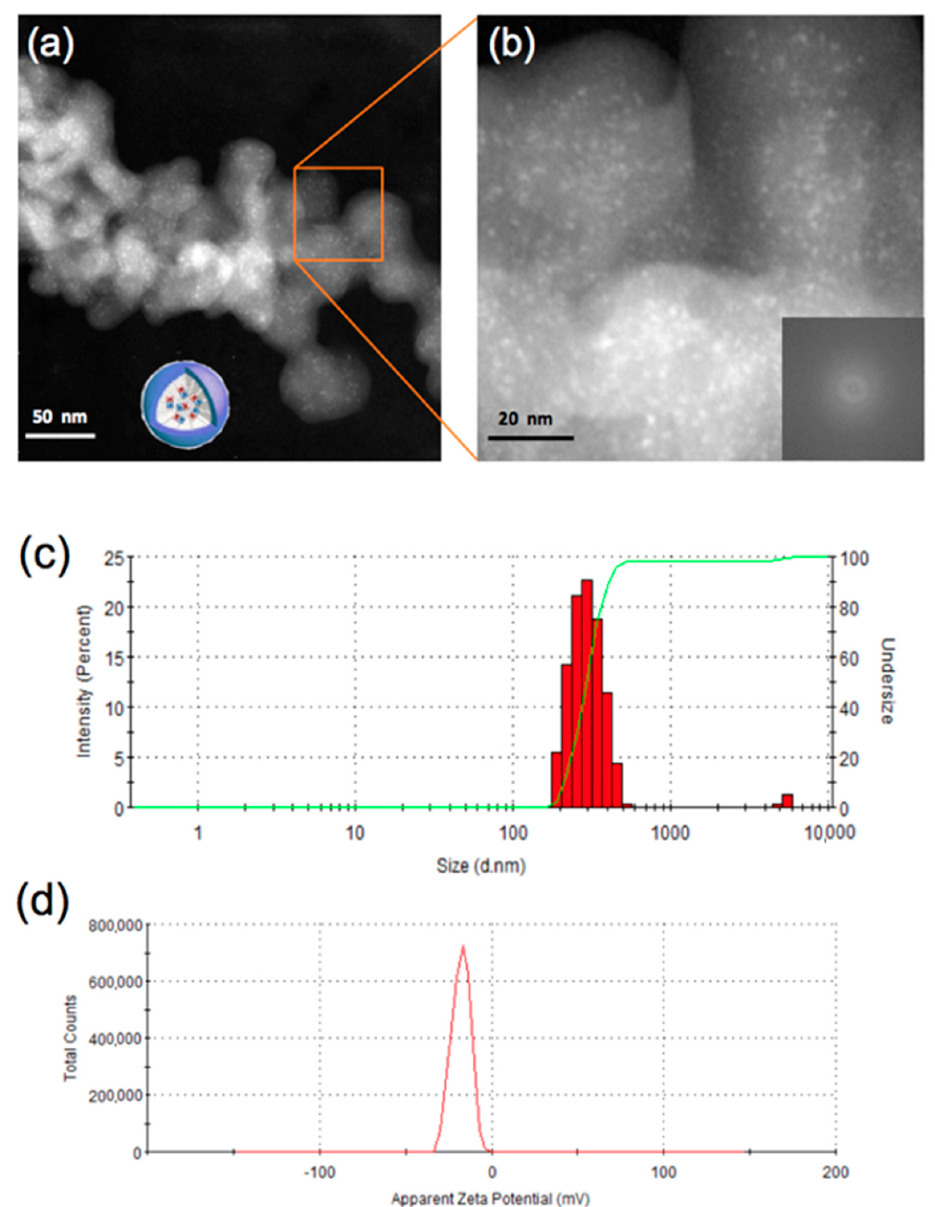
Figure 4. ( a ) Low-magnification STEM image of the as-prepared Tf-MTX-CSNAs. ( b ) The magnified STEM image of the NPs, showing their multicore-shell morphology. The FFT analysis (inset) shows that the NPs are amorphous, which confirms the organic basis of the NPs. ( c ) The DLS size distribution and ( d ) zeta potential analysis of Tf-MTX-CSNAs, exhibiting their good monodispersity and fair colloidal stability.